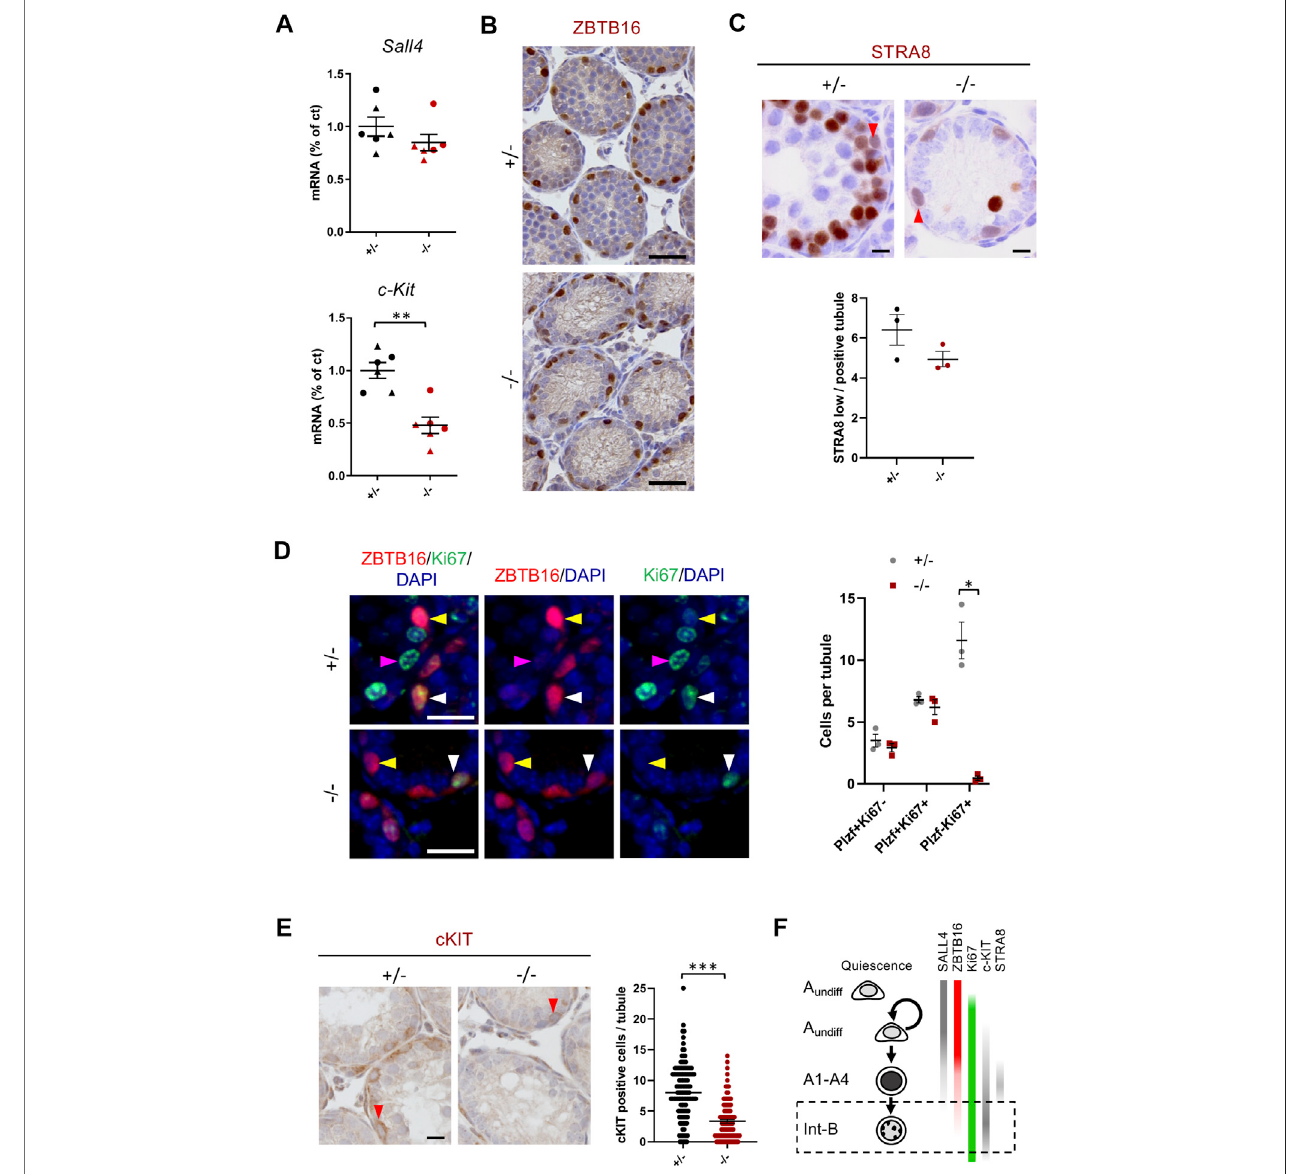
FIGURE 4 | The differentiated spermatogonia are altered in Cep250 -/- . (A) mRNA expression levels of the undifferentiated ( Sall4 ) and differentiated ( c-Kit ) spermatogonia cell markers were measured by RT-qPCR in the post-natal testes. Triangles represent 10 dpp values and circles represent 15 dpp values. β -actin was used as an endogenous reporter. Data are expressed as a percentage of the control expression level. Mean ± SEM. ** p < 0.01 (two-way ANOVA). (B) Histological analysis of 15 dpp testis sections stained for the undifferentiated and A-type differentiating spermatogonial cell marker ZBTB16 (brown). Scale bar: 50 µm. (C) Histological analysis of 15 dpp testis sections stained for the cell marker STRA8 (brown), expressed at low level in the differentiating A-type spermatogonia (red arrowheads) and at high level in the preleptotene cells. Scale bar: 5 µm. Quanti fi cation of the number of STRA8 low-positive cells per positive tubule is shown in the graph. (D) Immuno fl uorescence analysis of the spermatogonial cell markers ZBTB16 (red) and Ki67 (green) in 15 dpp testis sections. DNA is stained with DAPI. Yellow arrowheads indicate spermatogonia stained exclusively for ZBTB16 (ZBTB16+Ki67-); white arrowheads indicate spermatogonia stained for both ZBTB16 and Ki67 (ZBTB16+Ki67+); magenta arrowheads indicate germ cells stained exclusively for Ki67 (ZBTB16-Ki67+). Quanti fi cation is shown in the right panel. Mean ± SEM. * p < 0.05 (two-way ANOVA). Scale bar: 20 µm. (E) Histological analysis of 15 dpp testis sections stained for differentiating spermatogonia cell marker cKIT (brown). Red arrowheads indicate spermatogonia stained for cKIT. Scale bar 5 µm. Quanti fi cation of the number of cKIT positive cells per tubule is shown in the right panel. Mean ± SEM.** p < 0.01(two-wayANOVA). (F) Schematicrepresentation ofdifferentmarkersexpressed during spermatogonia differentiation. Thedashed rectangle represents the population of germ cells impaired in the Cep250 -/- male mice.